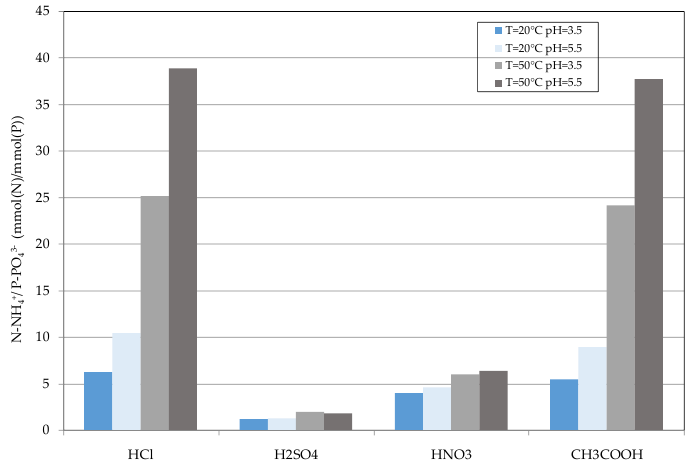
Figure 8. N:P molar ratio of dissolved ammonium and phosphorus, detected during the struvite decomposition tests